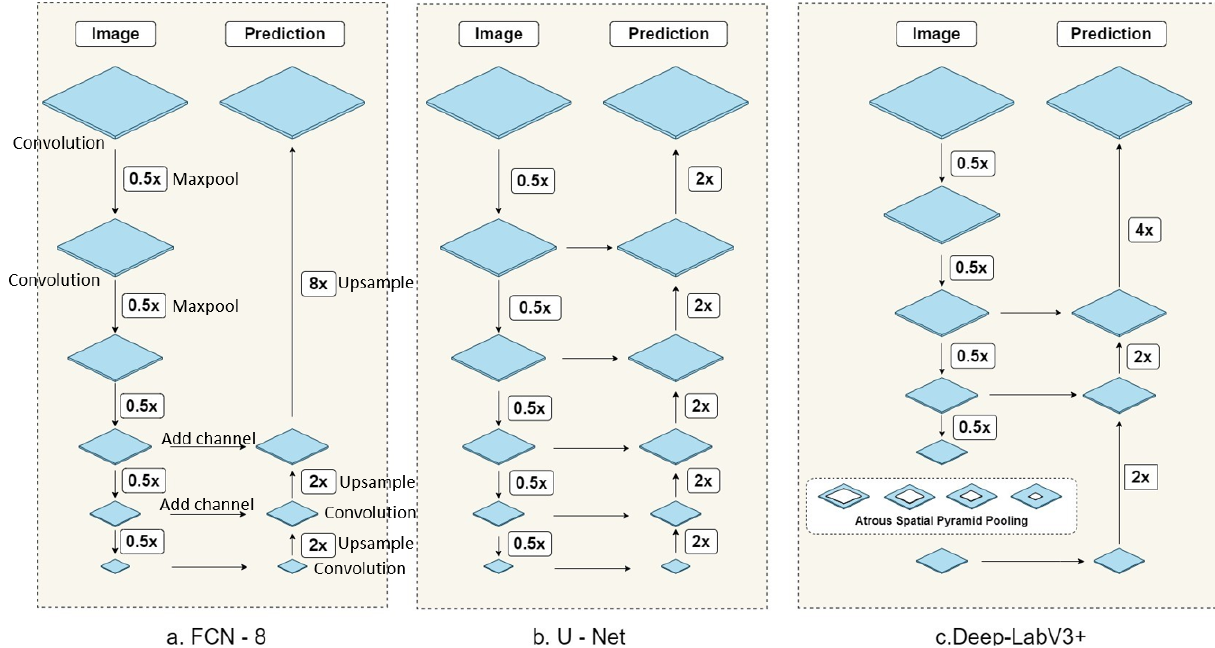
Figure 4. Architectures of ( a ) FCN-8, ( b ) U-Net, and ( c ) DeepLabv3+. The left downward flow of each model indicates the encoder part where the input is the three-channel color image. The right upward flow refers to the decoder part that outputs the final segmentation. Blue parallelograms indicate convolution operations; horizontal arrows from left to right show the channel additions from the encoder layers to the decoder layers; 0.5 × boxes with the down-arrows refer to the max pool operations; 2 × /4 × /8 × boxes with the up-arrows indicate the upsampling operation by 2, 4, and 8 factors, respectively. This figure is modified from